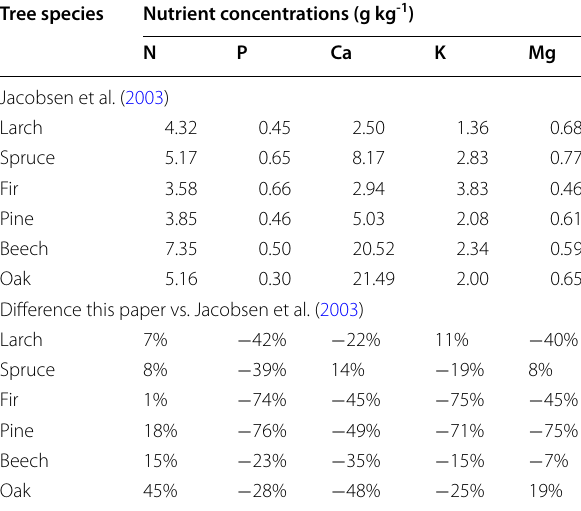
Table 13 Average nutrient concentrations in stem bark (g kg -1 ) according to Jacobsen et al. (2003), and relative difference (%) with dataset in this paper (see Table 1 for data; difference (%) this paper/Jacobsen et al. – 1) x 100%). Silver birch is not given in Jacobsen et al.,